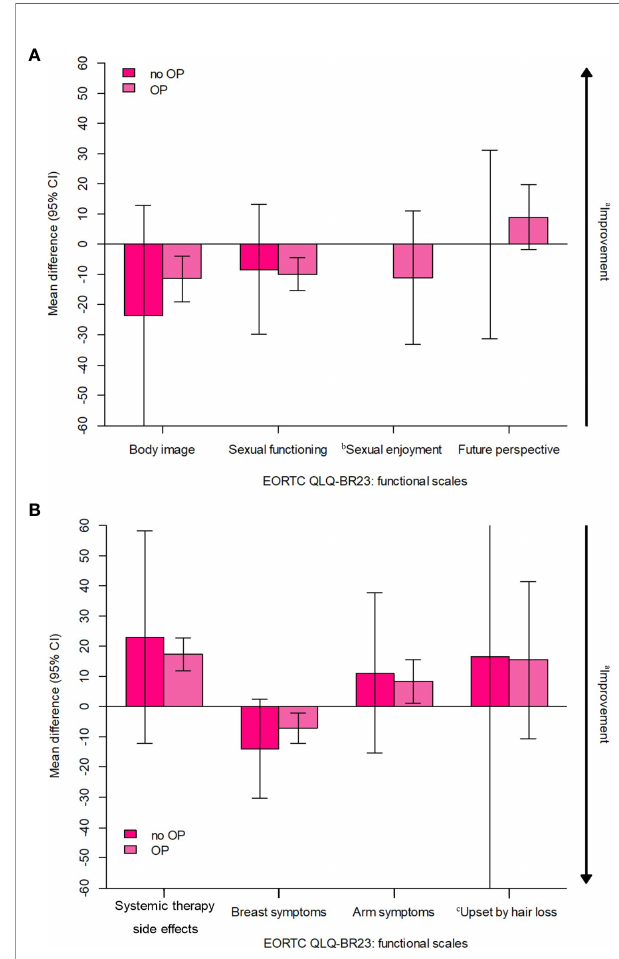
FIGURE 4 | Estimated overall change from baseline in 6 patients who refuse to undergo surgery after treatment (all received NET). CI, con fi dence interval; EORTC, European Organisation for Research and Treatment of Cancer; NET, neoadjuvant endocrine therapy; PRO, patient-reported outcome; QLQ-BR23, Quality of Life Questionnaiure Breast Cancer Module; QoL, quality of life. (A) EORTC QLQ-BR23; functional scales, (B) EORTC QLQ-BR23: symptom scales. a Arrow denotes direction of improved outcome. b The sample sizes for the "sexual enjoyment" functional scale was smaller than other fuctional scales because patients were asked to respond to this question only if they responded in a previous question that they were sexually active. c The sample sizes for the "upset by hair loss" symptom scale was smaller than other symptom scales because patients were asked to respond to this question only if they responded in a previous question that they were experiencing hair